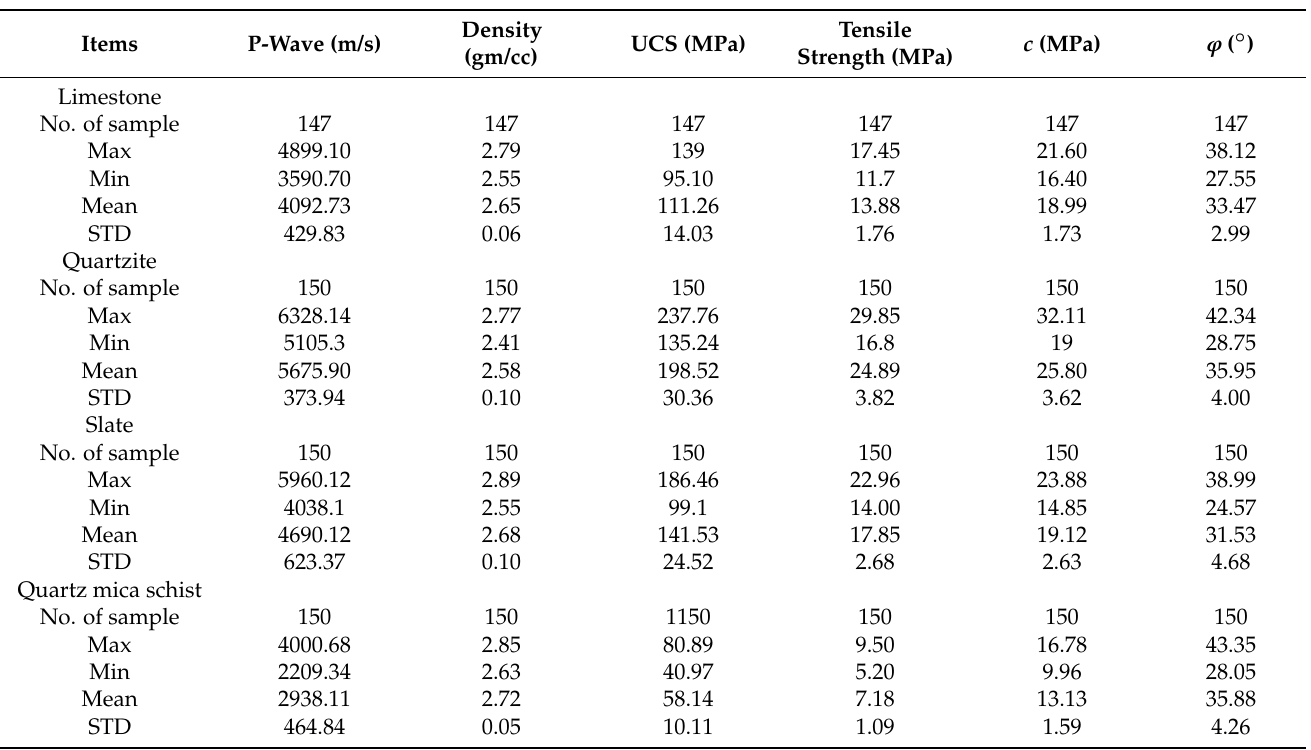
Table 1. Lithology-based minimum and maximum, mean, and standard deviation (STD) values of the dataset in this